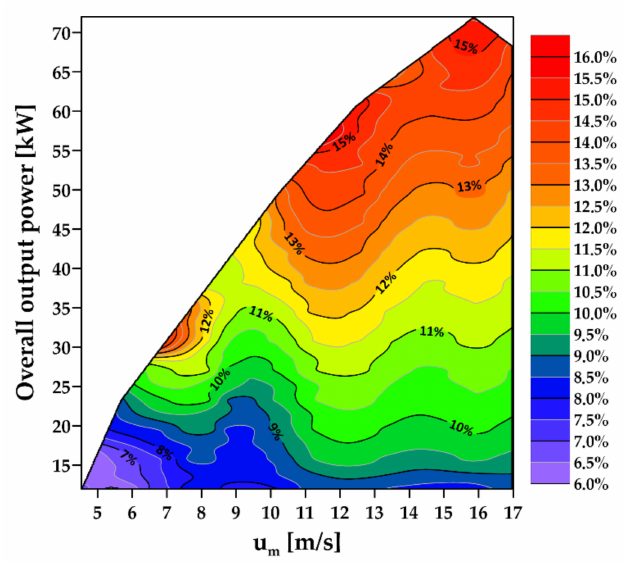
Figure 18. Efficiency improvement of the compound engine with respect to reference turbocharged engine as function of power output and mean piston speed for T 4 /T 1 = 4.5 and η T =